Question: Reading the figure, is the described quantity rising or falling?
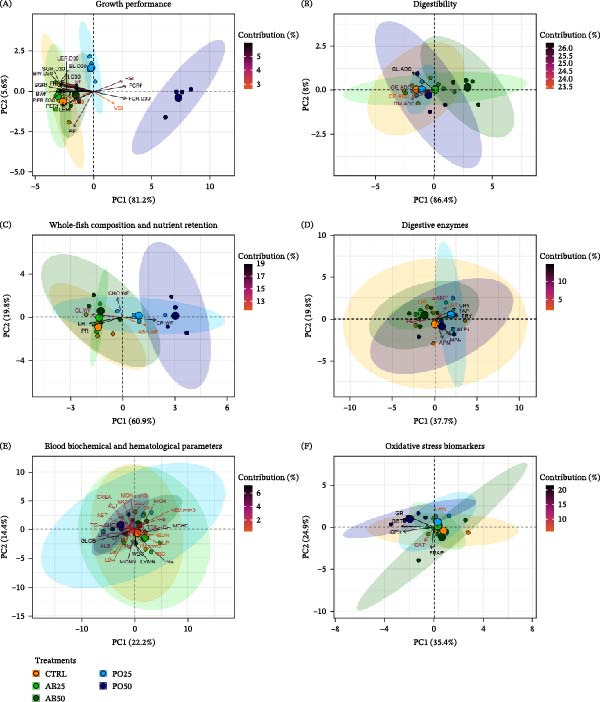
Answer: increasing